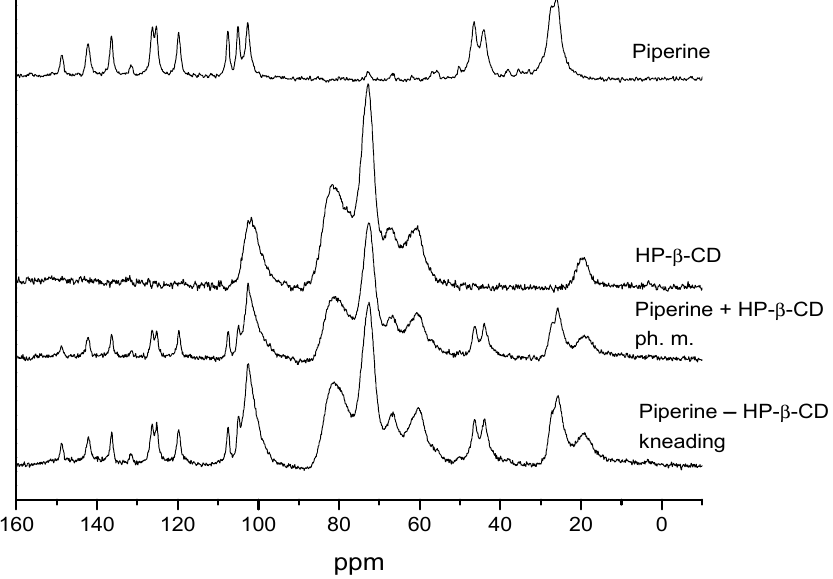
Figure 6. 13 C NMR spectra of piperine, HP- β -CD, physically mixed compounds, and kneaded compounds.